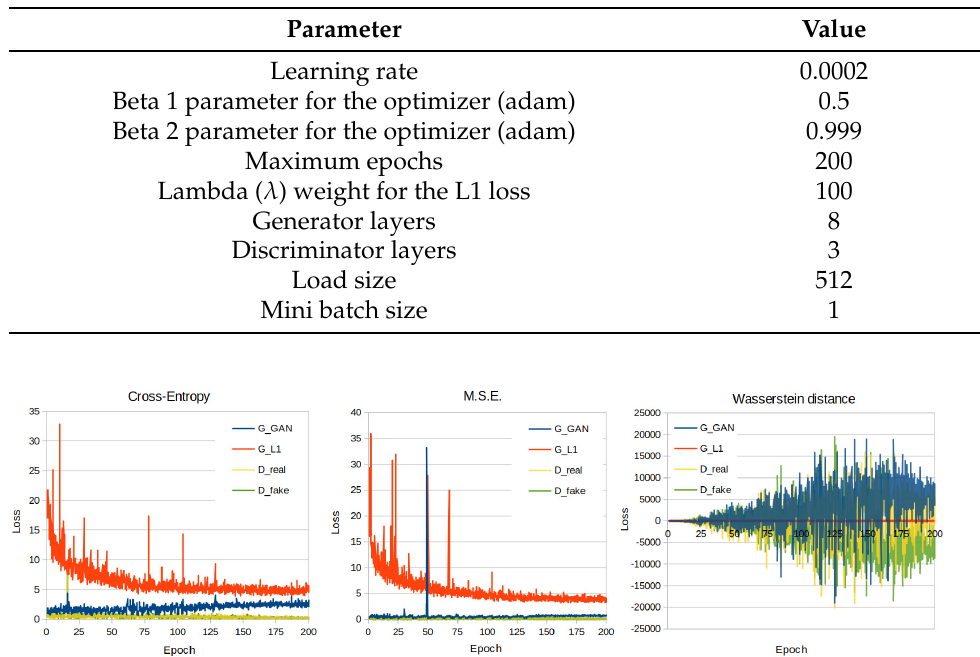
Table 2. Values of important adjustable training parameters and hyperparameters.